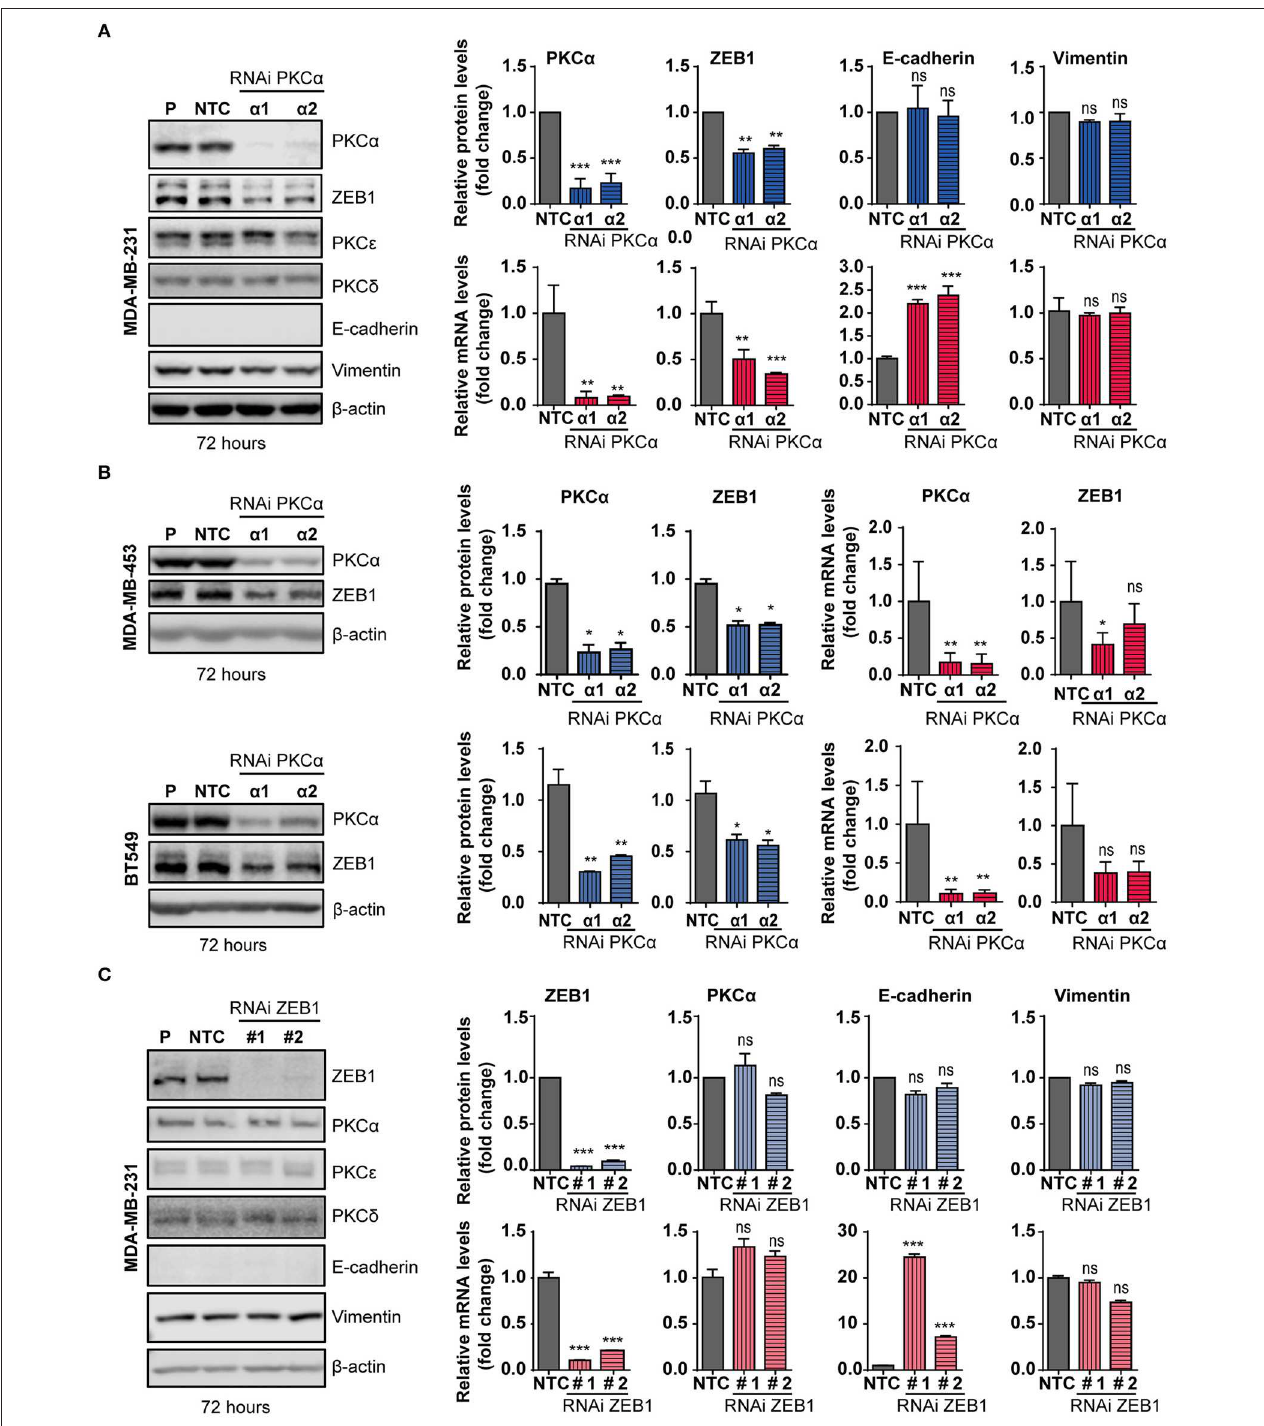
FIGURE 3 | PKC α silencing or inhibition downregulates ZEB1 levels. MDA-MB-231 (A) , MDA-MB-453 and BT549 (B) cells were transfected with specific PKC α RNAi duplexes ( α 1 and α 2) or the non-target control RNAi ( NTC ). Western blot analysis for PKCs and EMT markers was carried out 72h later. P , parental cells. Blue bar graphics represent protein levels (fold-change) normalized to β -actin and relativized to the NTC. mRNA levels of PKC α , ZEB1, E-cadherin and vimentin (A) or PKC α and ZEB1 (B) were assessed by RT-qPCR and results were plotted on the red bar graphics (fold-change) normalized to the housekeeping gene UBC and relativized to NTC. (C) MDA-MB-231 cells were transfected with specific RNAi duplexes for ZEB1 (#1 and #2) or NTC RNAi. Western blot analysis for PKCs and EMT markers was carried out 72h later. The graphics (blue bars) represent the quantification (fold-change) normalized to β -actin and relativized to the NTC. PKC α and ZEB1 mRNA levels were represented on the red bar graphics as fold-change, normalized to the UBC and relativized to the NTC. Results are expressed as mean ± S.D. ns , not significant; * p ≤ 0.05; ** p ≤ 0.01; *** p ≤ 0.001.